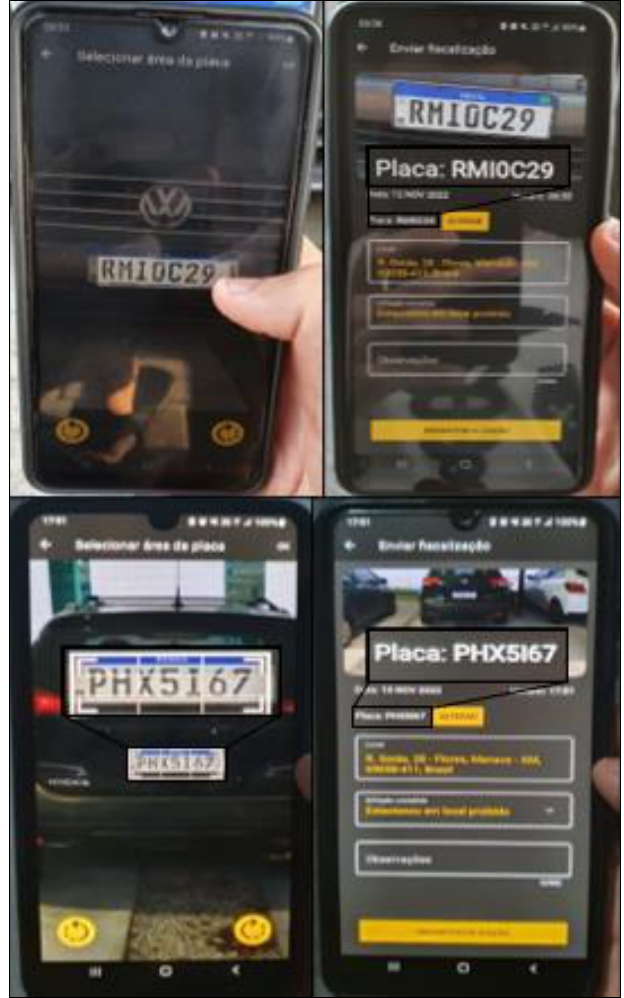
Figure 14: Application prototype tests’